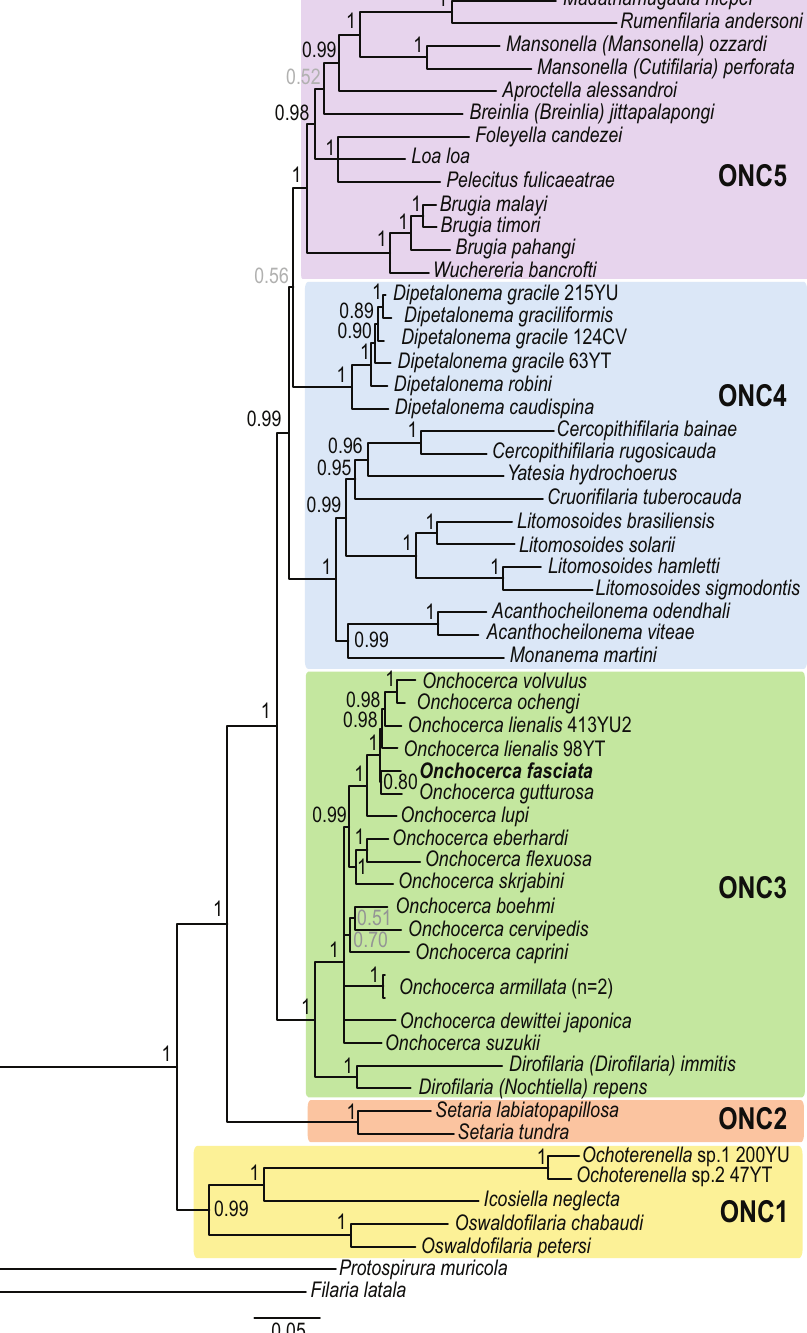
Figure 3. Phylogeny of filarial nematodes based on partitioned concatenated datasets of seven markers. Analysis is based on 12S rDNA, cytochrome oxidase subunit I ( cox 1), RNA polymerase II large subunit ( rbp1 ), heat shock protein ( hsp70 ), myosin heavy chain ( myoHC ), 18S rDNA and 28S rDNA sequences. Filaria latala and Protospirura muricola were used as outgroups. The topology was inferred using Bayesian inference. Nodes are associated with Bayesian posterior probabilities based on one run of five million generations. The onchocercid groups are indicated as ONC1 to ONC5 according to Lefoulon et al. [24]. Bold represents the newly sequenced